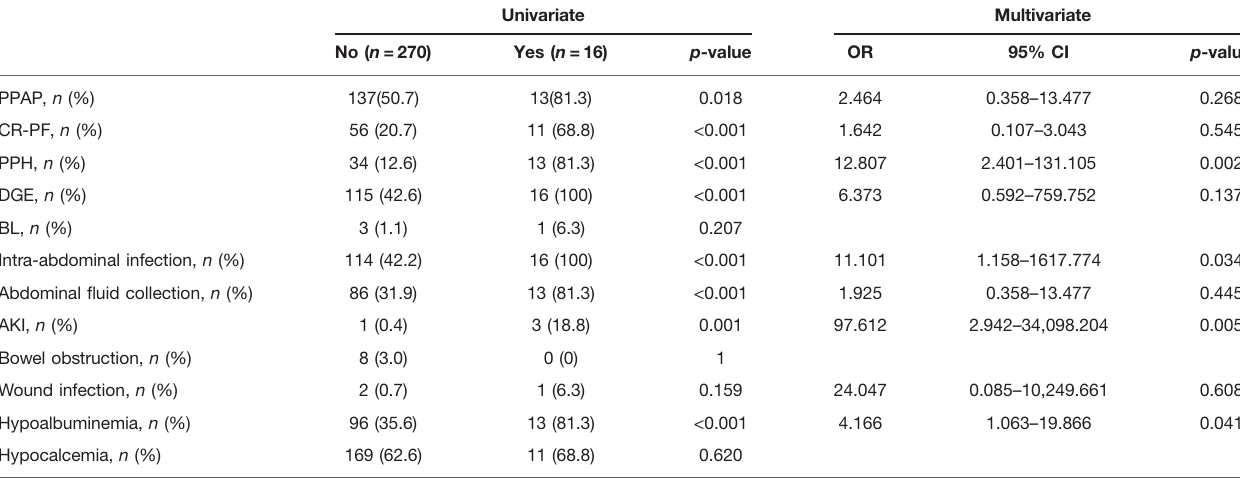
TABLE 2 | Univariate and multivariate analyses of Clavien – Dindo ≥ IIIb postoperative complications. Univariate